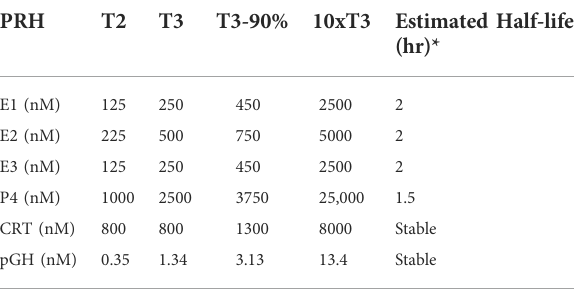
TABLE 2 Concentrations of exogenously administered pregnancy related hormones (PRH) in the experimental